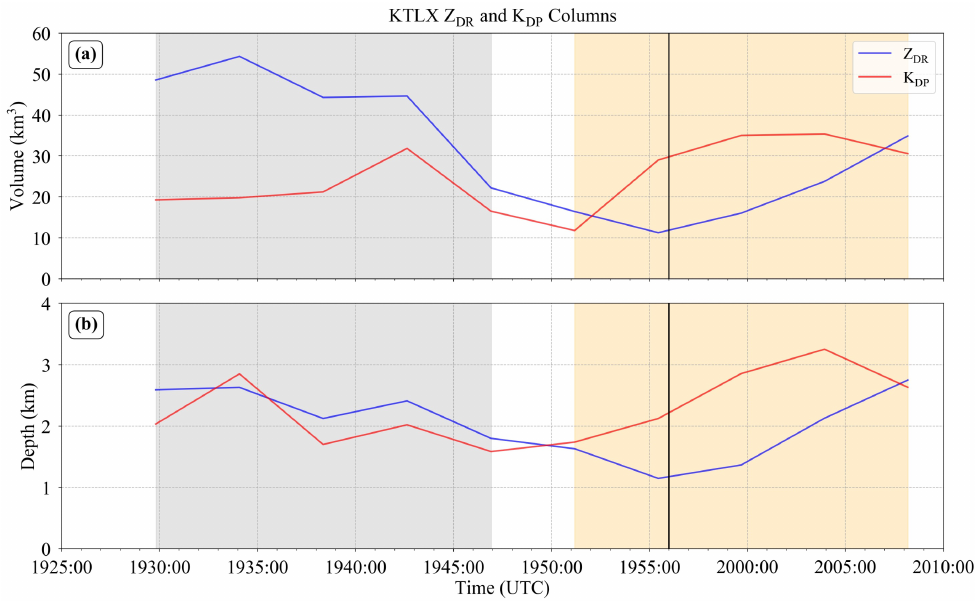
Figure 15. Using KTLX: ( a ) volumetric extent of the Z DR and K DP columns and ( b ) 90th percentile of the depth for both columns. The gray and orange shaded regions mark the first and second period, respectively, with the solid black vertical line denoting the time of